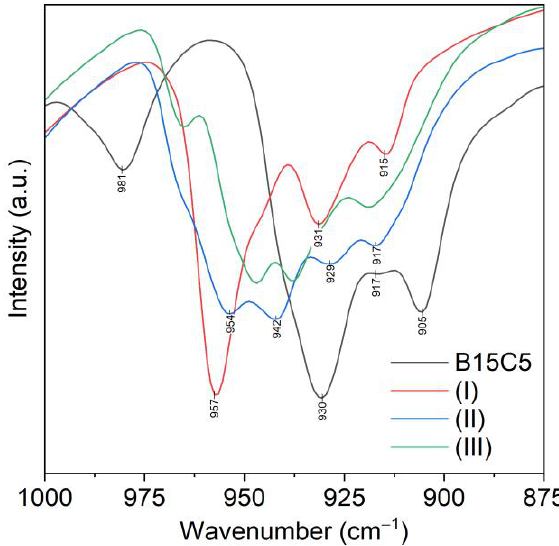
Figure 12. Fragments of FTIR spectra of B15C5; ( I )—[Li(B15C5)(H 2 O)(NTf 2 )]; ( II )—[Li(B15C5) 1.5 (H 2 O)](NTf 2 ); ( III )—[Li(B15C5) 2 (H 2 O)](NTf 2 Table 2. Vibration frequencies of coordinated water molecules in spectra (I – III) (cm – 1 ). Complex